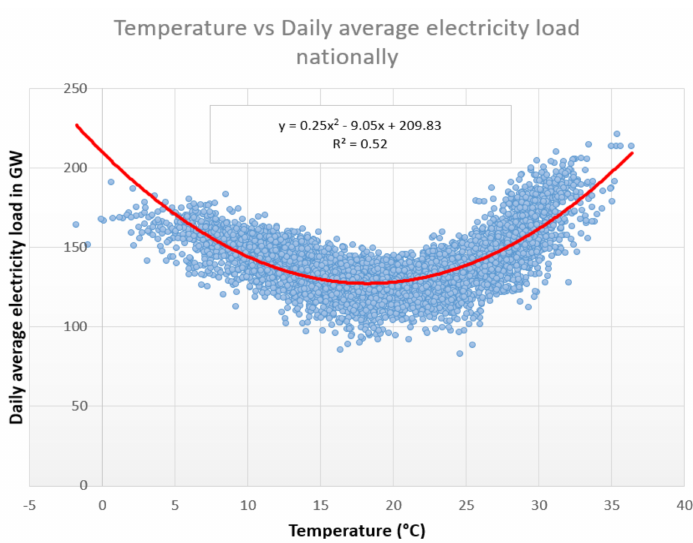
Figure 1. Electricity load temperature dependence for the mainland grid of